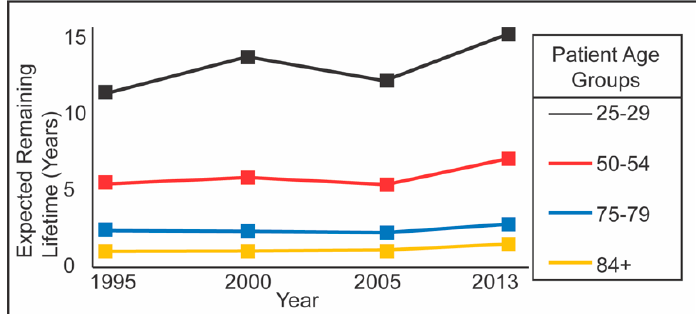
Figure 1. Expected remaining lifetime of end-stage renal disease (ESRD) patients on hemodialysis (HD) for the past two decades. For all age groups of ESRD patients, there has been no significant improvement in life expectancies [9]. This demonstrates a need for disruptive technologies in the field of hemodialysis.